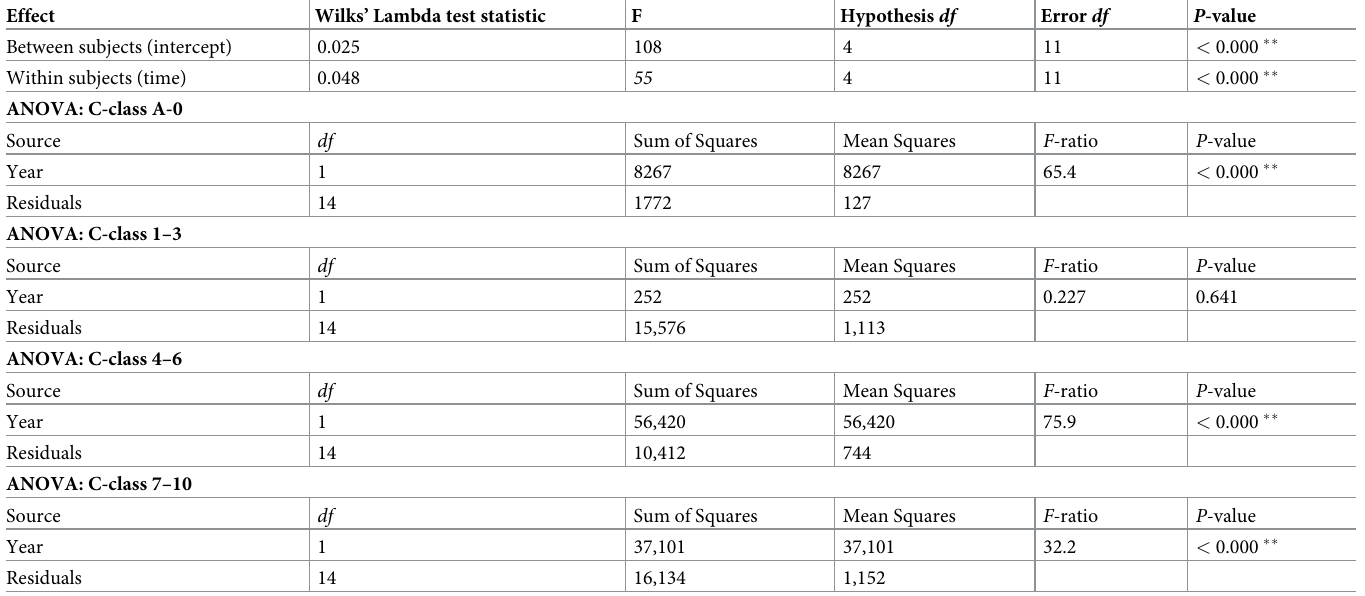
Table 3. Repeated measures MANOVA comparing cover by species within four conservatism classes for the years 1986 and 2019 (see also Fig 7). Individual ANO- VAs for each cover class follow.